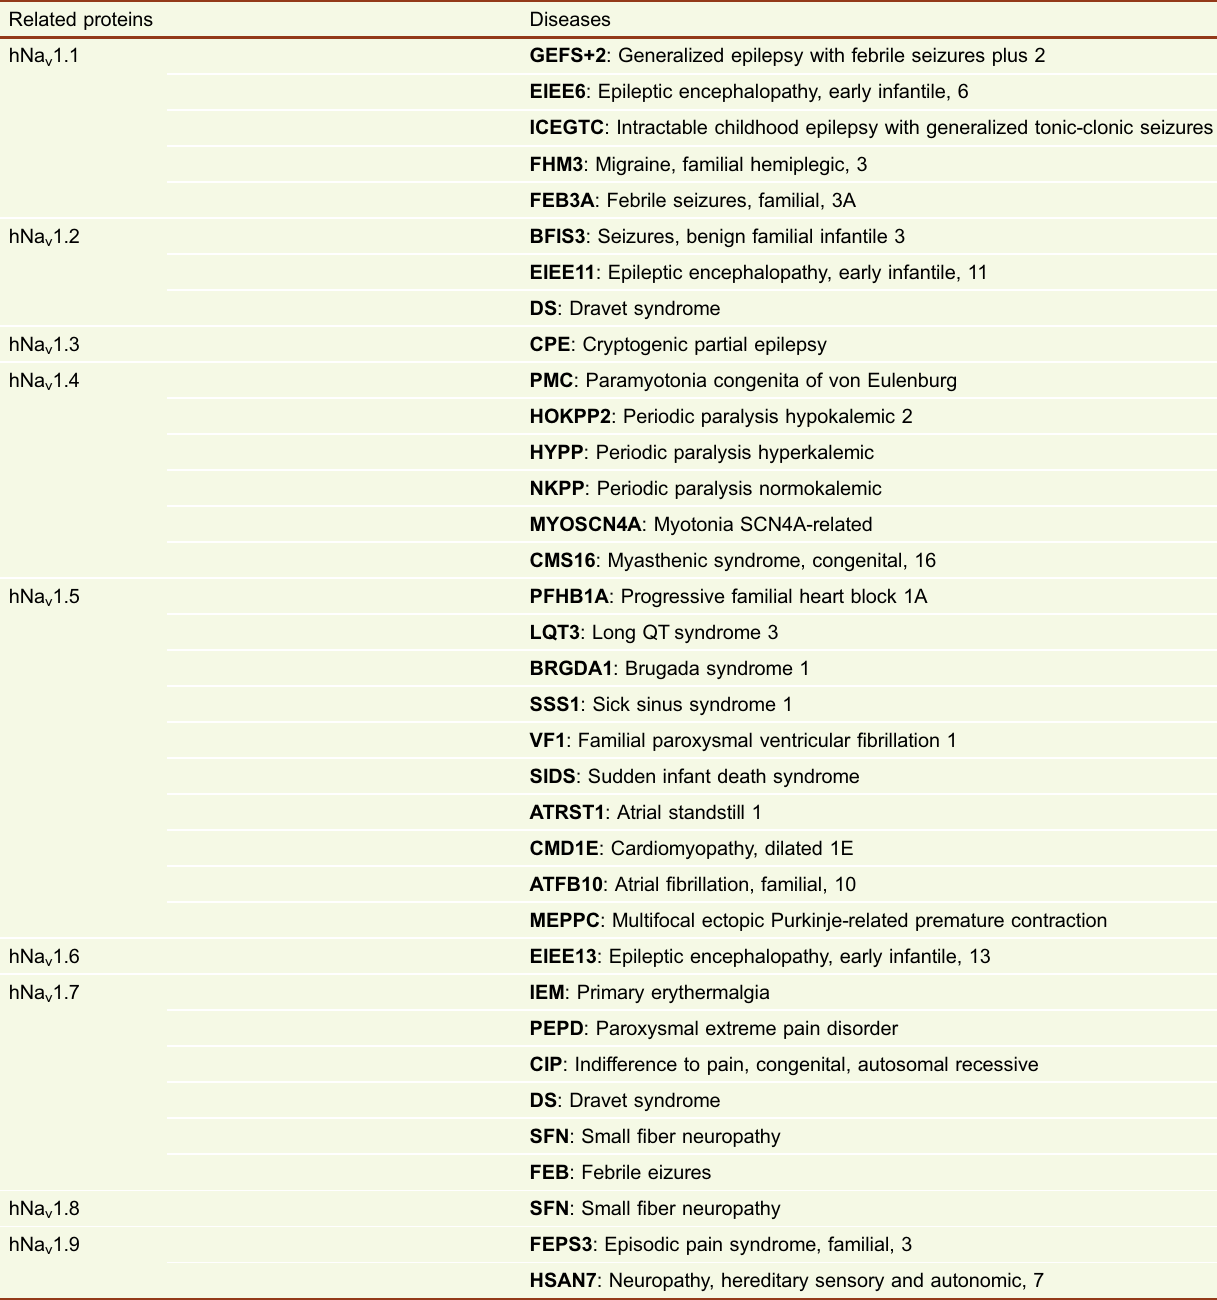
Table 10. Summary of sodium channelopathies Related proteins